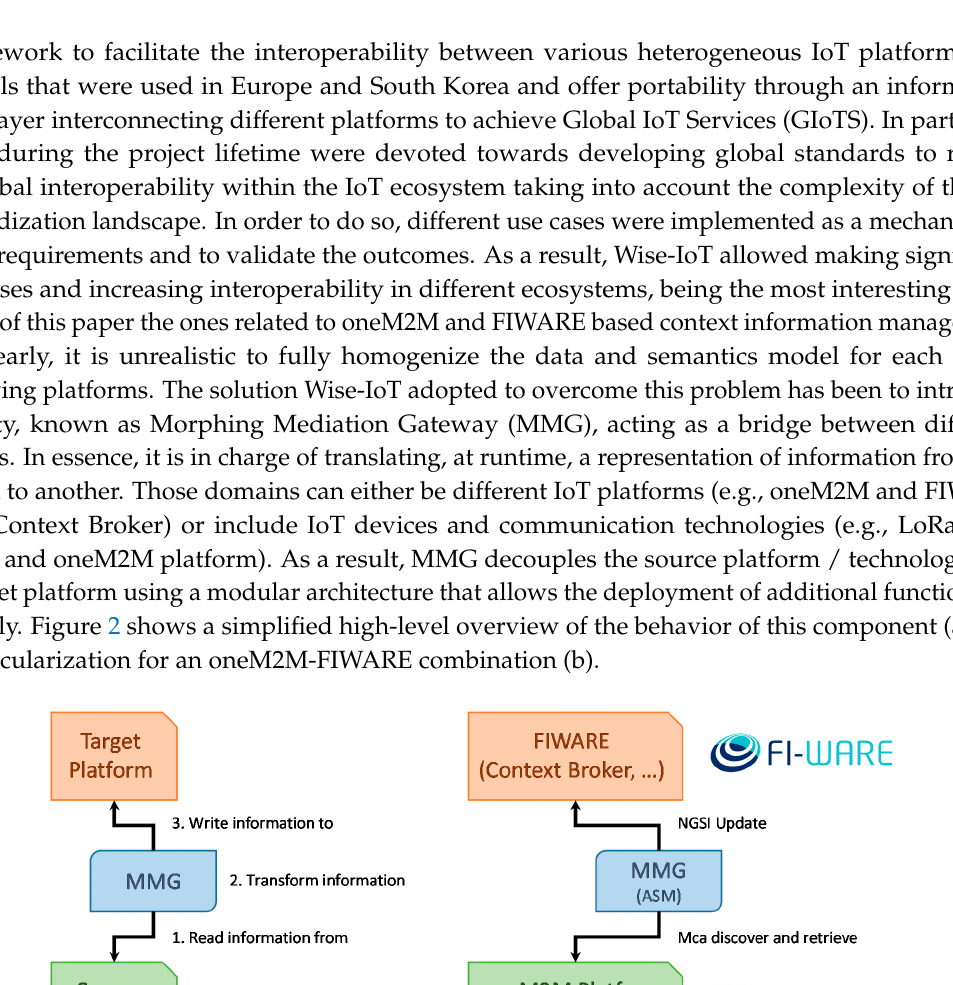
Figure 3. FIWARE NGSI context information model.